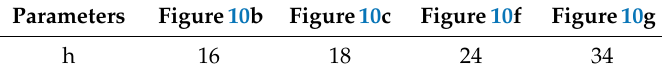
Figure 10. Visual comparison of wildlife image segmentation: ( a , e ) the original image; ( b , f ) the best segmentation results of the traditional mean-shift algorithm; ( c , g ) the segmentation result of the proposed algorithm; and ( d , h ) the extraction result of the proposed algorithm.